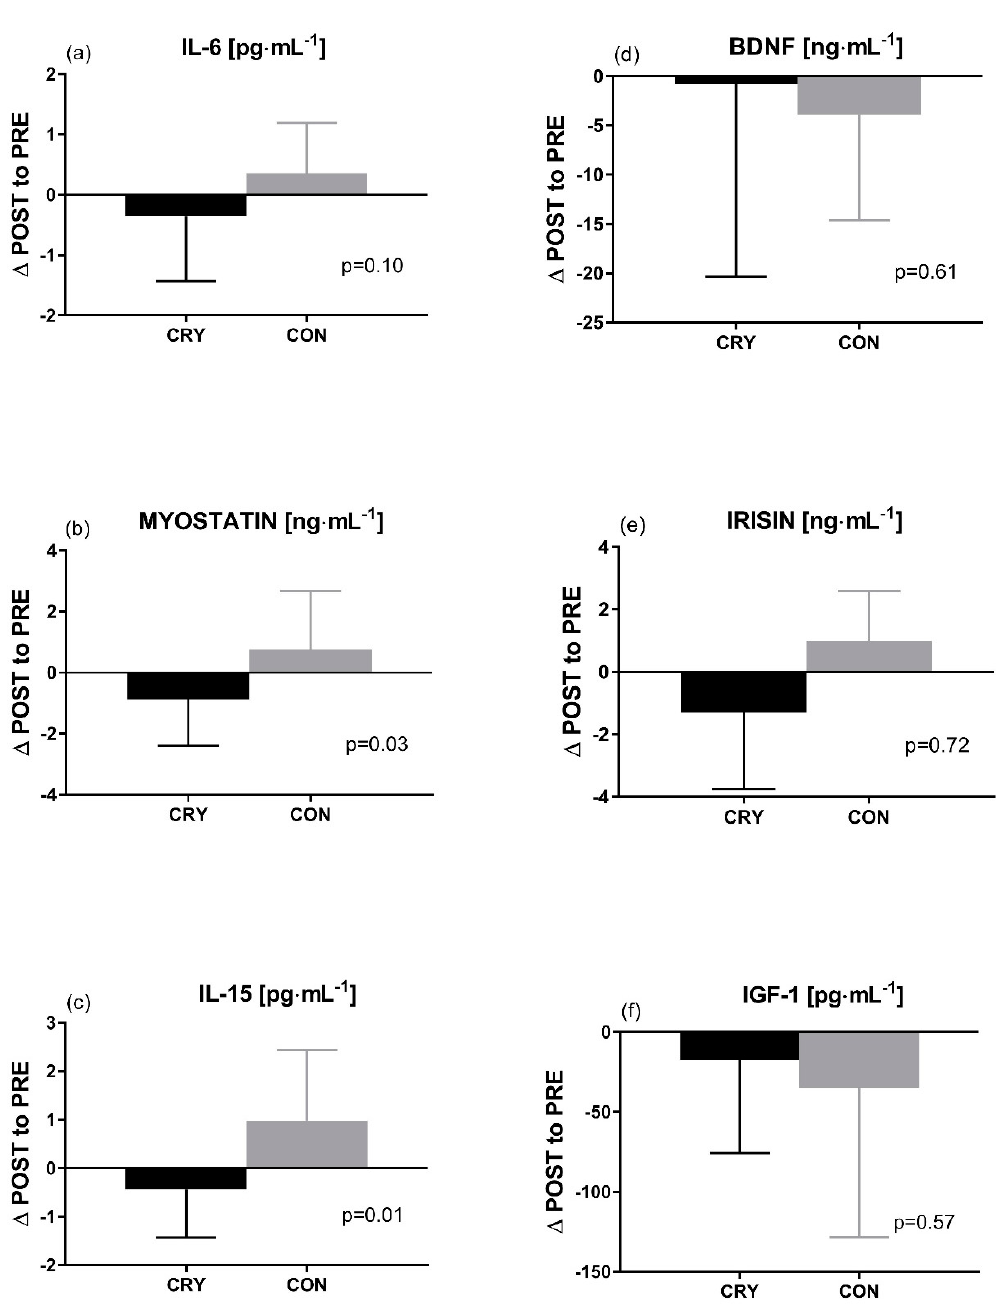
Figure 4. Delta changes ( ∆ POST to PRE) in serum myokine and growth factor concentrations at rest: before and after 4 weeks of resistance training combined with whole-body cryostimulation or passive rest; ( a ) interleukin 6 (IL-6), ( b ) myostatin, ( c ) interleukin 15 (IL-15), ( d ) brain-derived neurotrophic factor (BDNF), ( e ) irisin, ( f ) insulin-like growth factor (IGF-1); POST—post-intervention values, PRE—pre-intervention values, CRY—cryotherapy group, CON—control group; p < 0.05. The probability of an e ff ect being practically worthwhile was calculated according to the magnitude-based inference